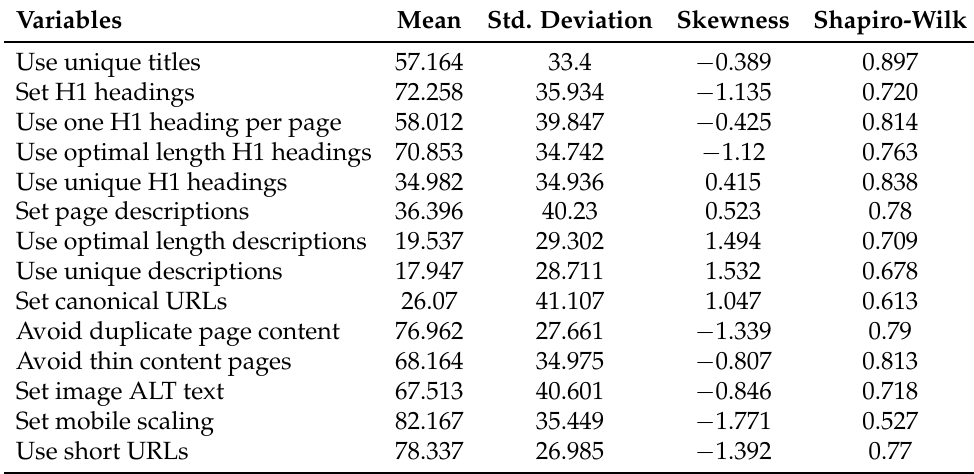
Figure 2. Bar chart included the number of CMSs types among the 341 examined websites. Table 4. Descriptive statistics results for the variables included within Content Curation